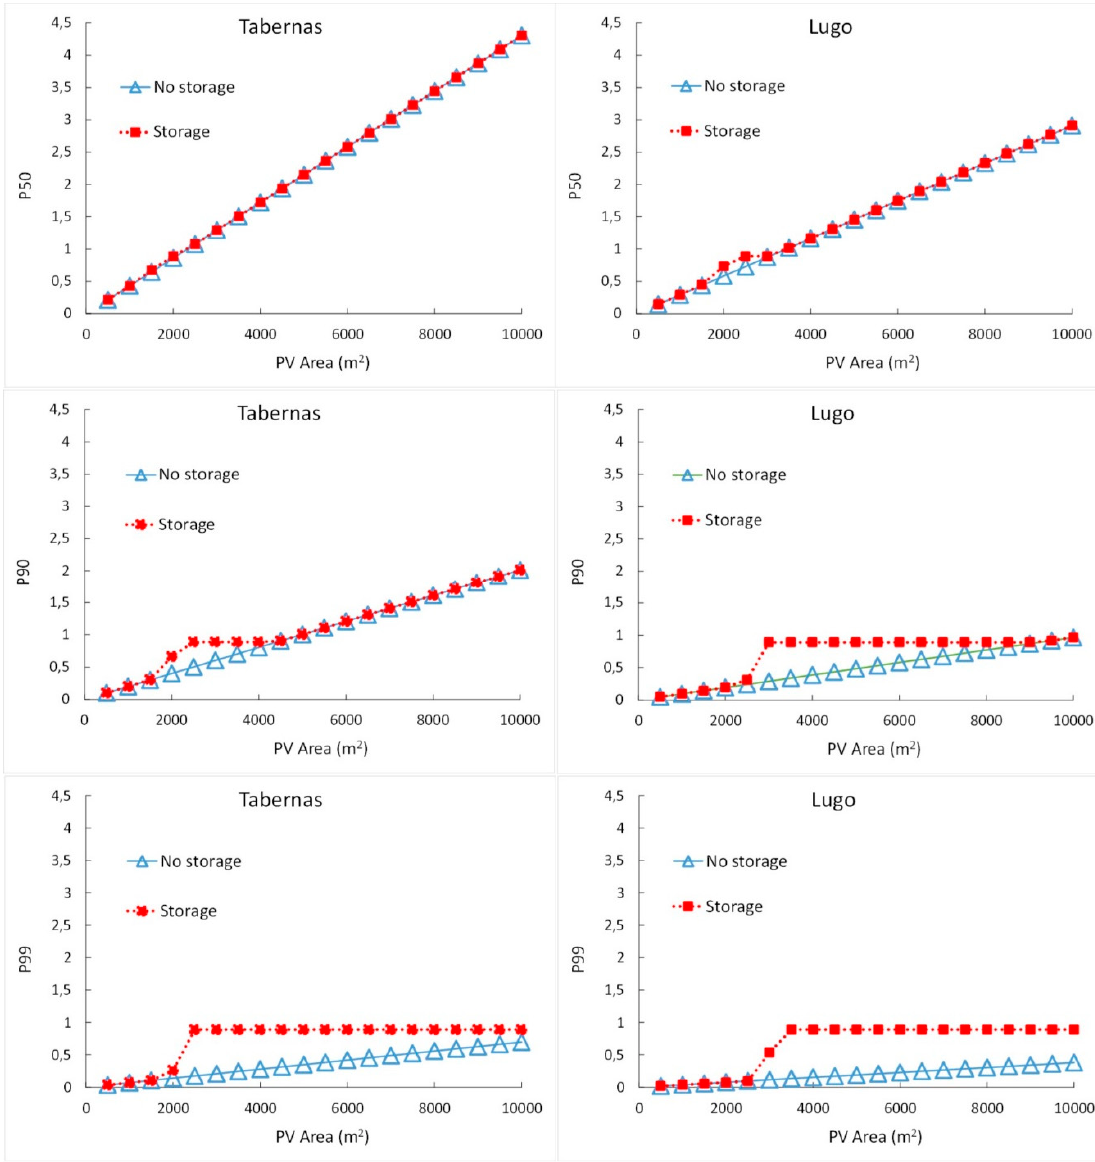
Figure 7. Exceedance probabilities according to the PV installation area.